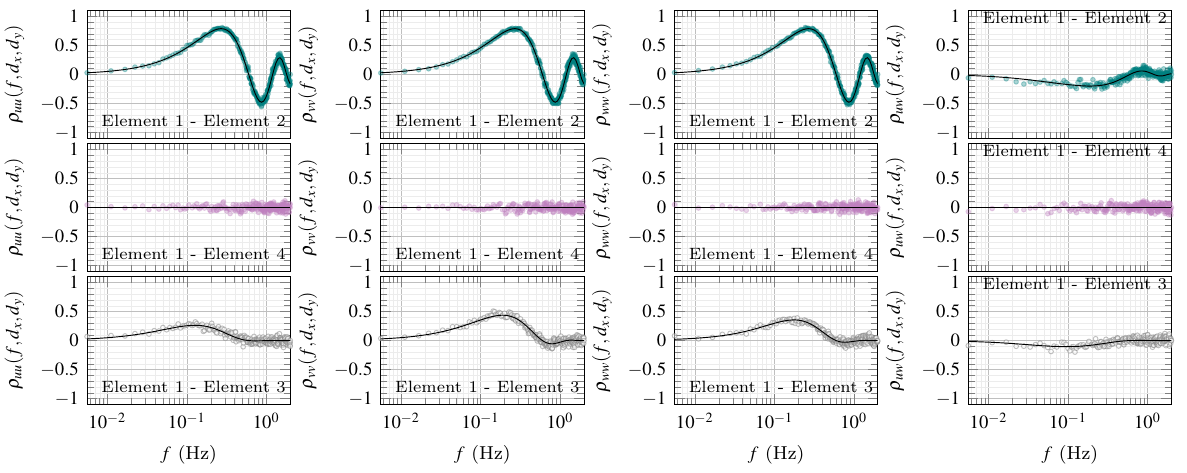
Figure 11. Target quad-coherence (solid lines) and estimated one (markers) between elements 1 and 2 ( top panels ), elements 1 and 4 ( middle panels ) and elements 1 and 3 ( bottom panels ) of the diamond